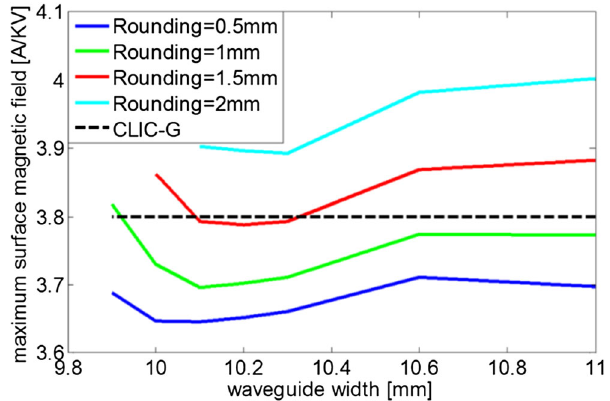
FIG. 9. Maximum magnetic field versus rounding and wave- guide width.